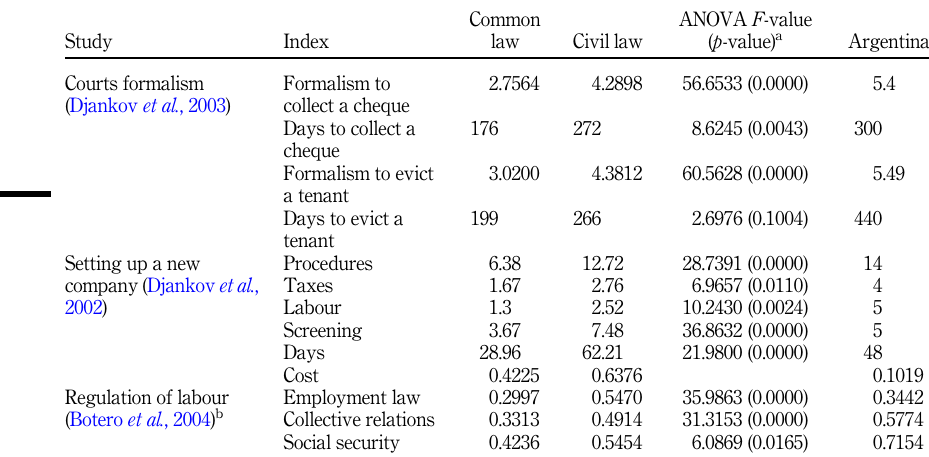
Table 1. Common and Civil law differences, identification of Argentina as an extreme case